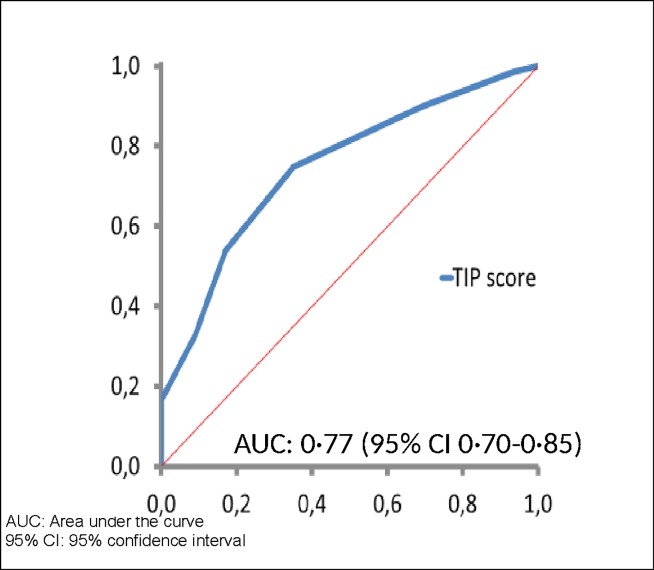
ROC curve derived from the MEGA study.